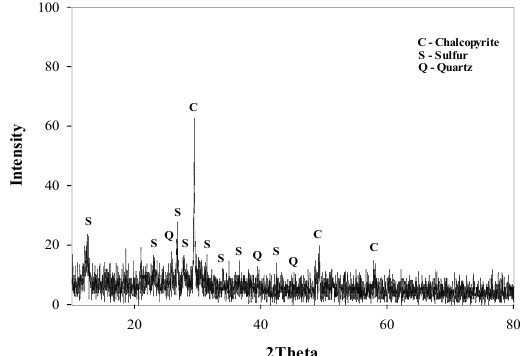
Fig. 7. X-ray diffractograms of leaching residue (Sample 1)